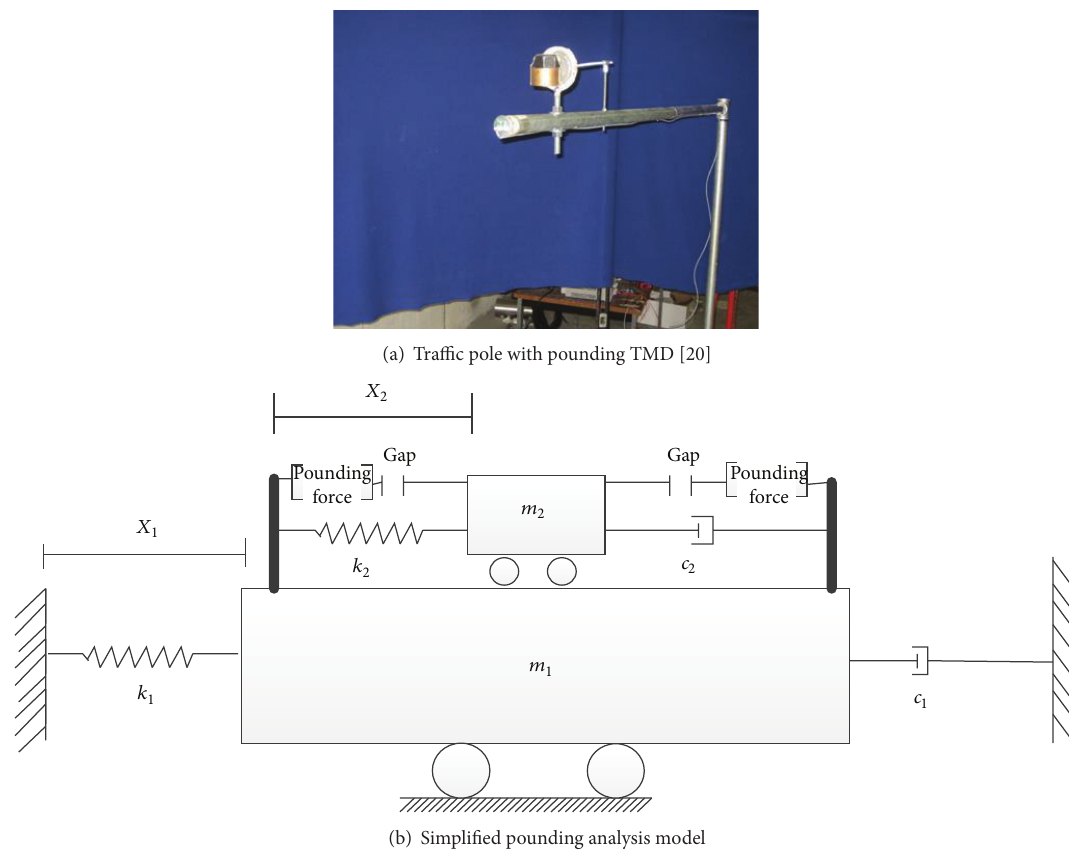
Figure 13: Traffic pole device and simplified pounding TMD